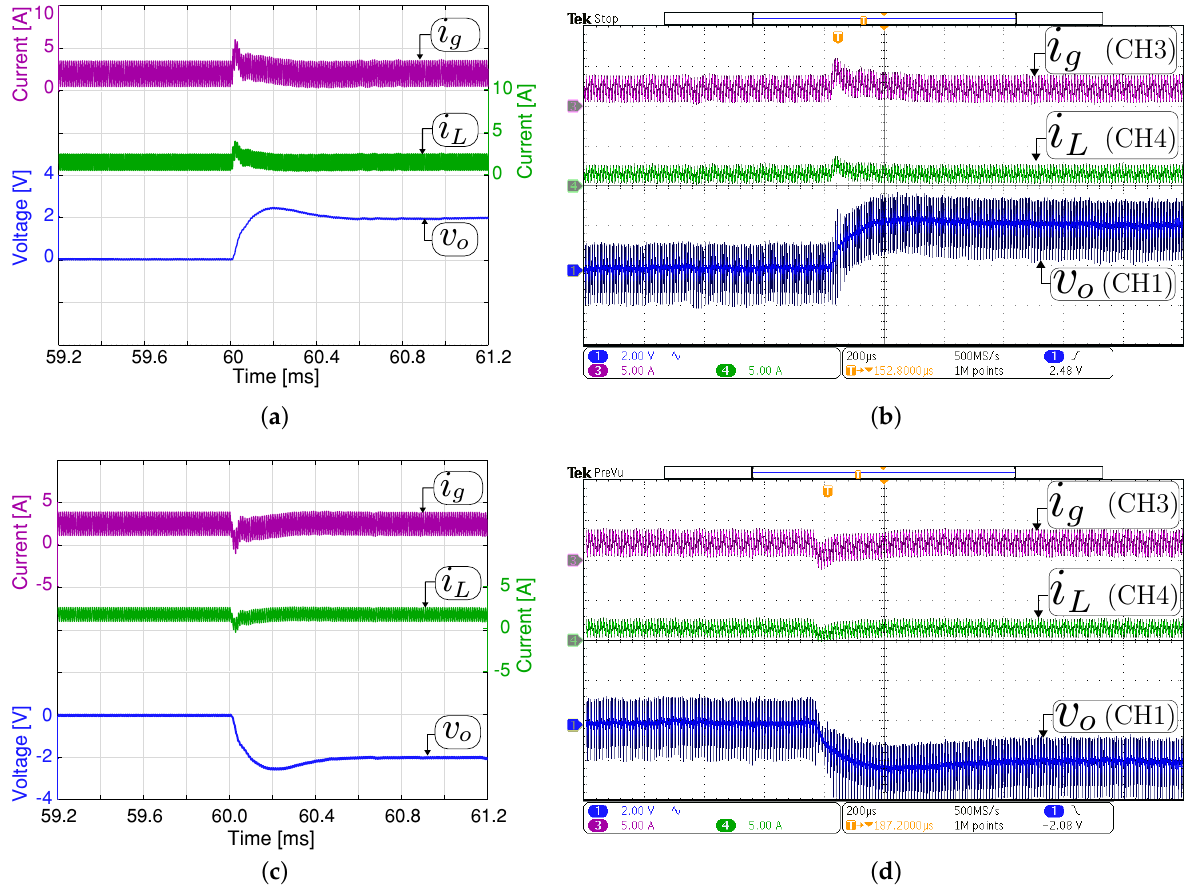
Figure 8. Small signal transient response with a constant resistive load R o = 200 Ω in boost mode ( V g = 200 V). Simulated ( a , c ) and experimental ( b , d ). Transient response when the output voltage reference changes from 294 to 296 V ( a , b ), and from 296 V to 294 V ( c , d ). CH1: v o (2 Vac/div), CH3: i g (5 A/div), CH4: i L (5 A/div), and time base of 200 µ